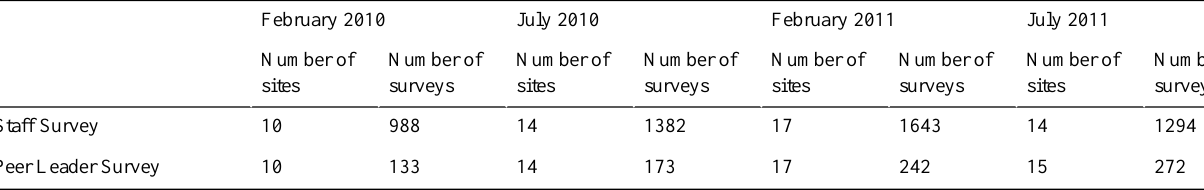
Table 3. Tier 2 peer and staff surveys administration times and sample size.